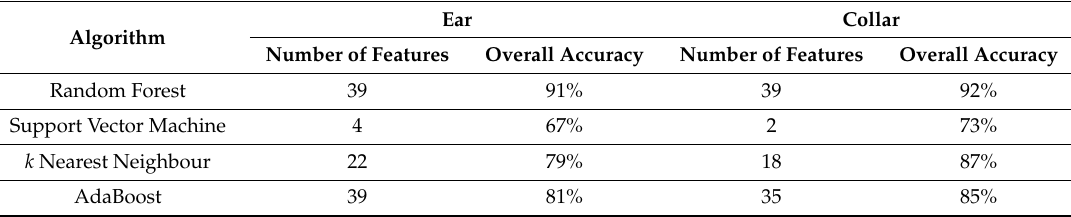
Table 4. Maximum overall accuracy values of different learner types trained algorithm using all 44 features for each ear and collar